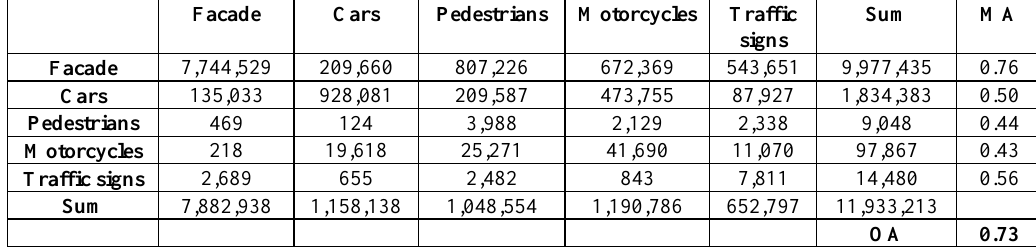
Table 2. Confusion matrix (i.e. numbers of points) of the five classes showing also the mapping accuracy (MA) and the overall accuracy (OA)